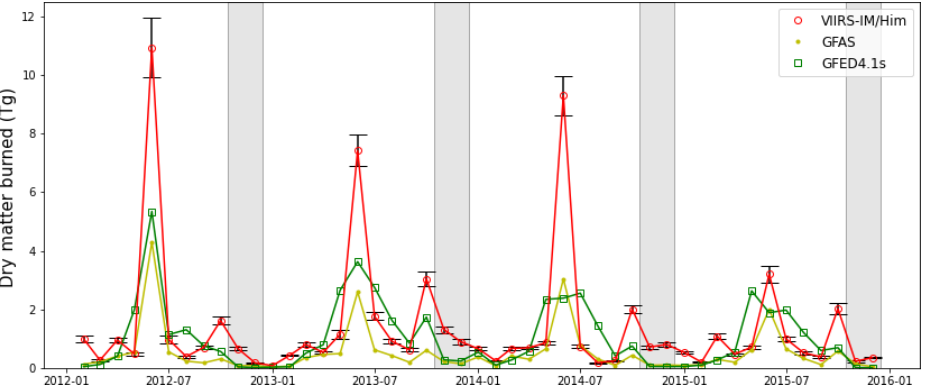
Figure 7. Monthly (2012–2015) time series of total dry matter burned (DMB) retrieved using the VIIRS-IM/Him FRP product developed in this study (with standard deviation shown as black error bars), along with comparable GFAS and GFED4.1s DMB totals. Grey shaded areas highlight the winter burning season from mid-November to December (Sect.